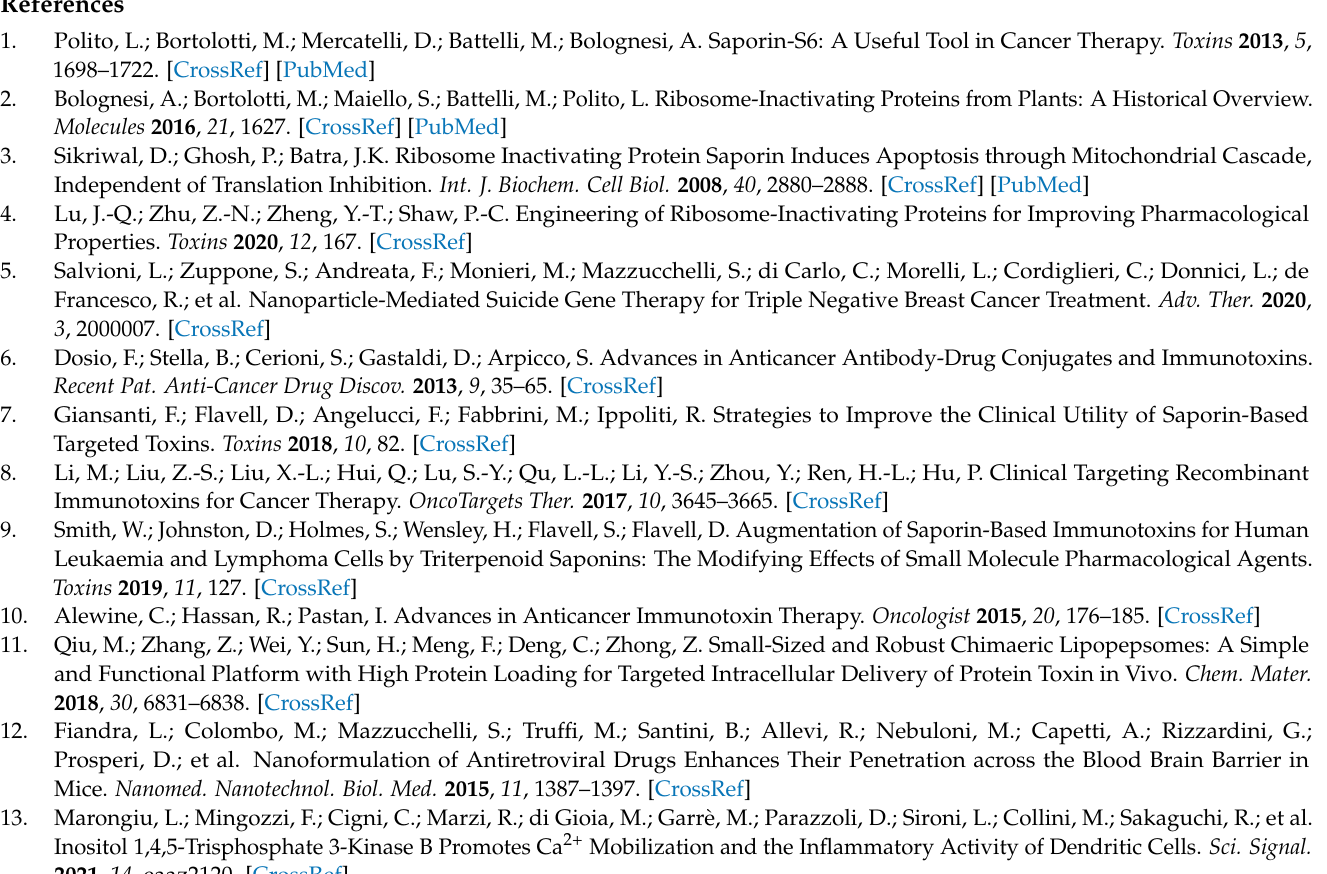
Saporin; Figure S2: Assessment of MYTS-Sap binding specificity. Table S1: Correlation between Sap and MYTS concentrations in MTT